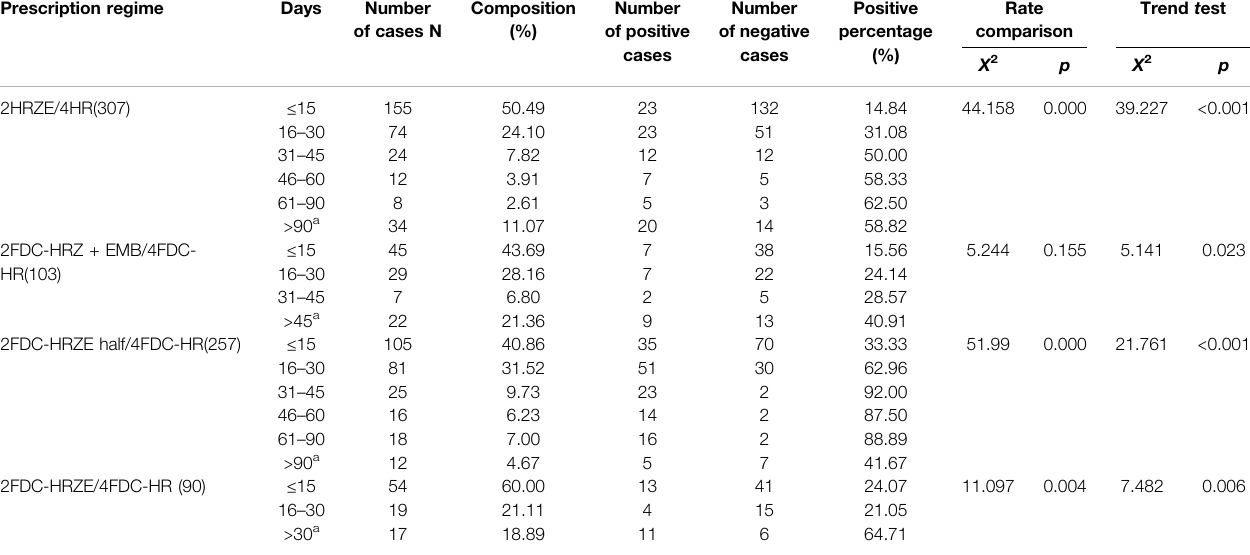
TABLE 5 | Liver function positive rate versus the duration of anti-TB drug treatment. Prescription regime